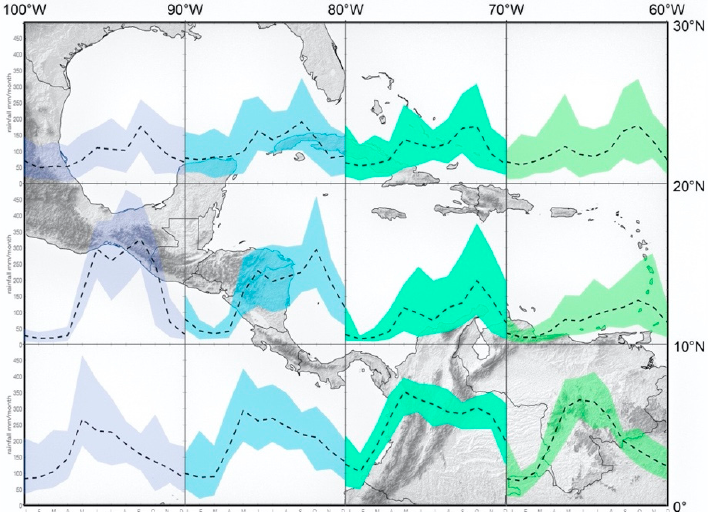
Figure 4. Average annual cycle of rainfall for contiguous 10° × 10° areas as shown in the boxes based on monthly Global Precipitation Measurement (GPM) for the 2001–2019